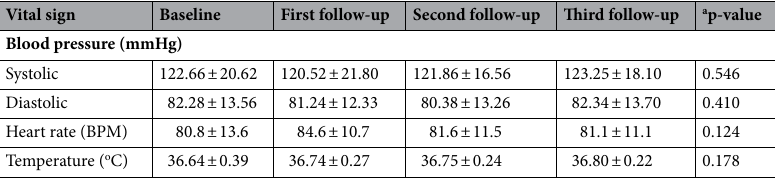
Table 1. Characteristics of participant.